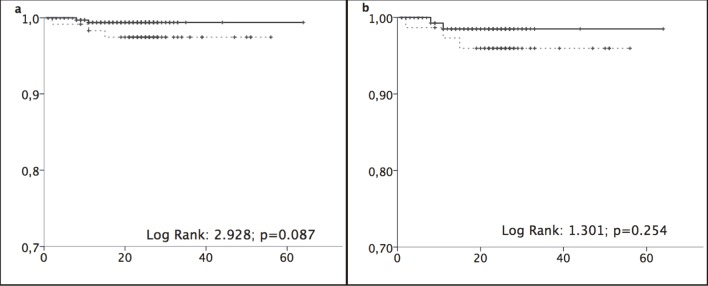
Liver-related mortality.(a) Liver-related mortality. (b) Liver-related mortality in stage F4 patients. Kaplan–Meier curves were compared using log-rank tests between patients aged ≥65 years (black lines) and <65 years (grey dotted lines). Abscissa: time in months. Ordinate: cumulative survival.